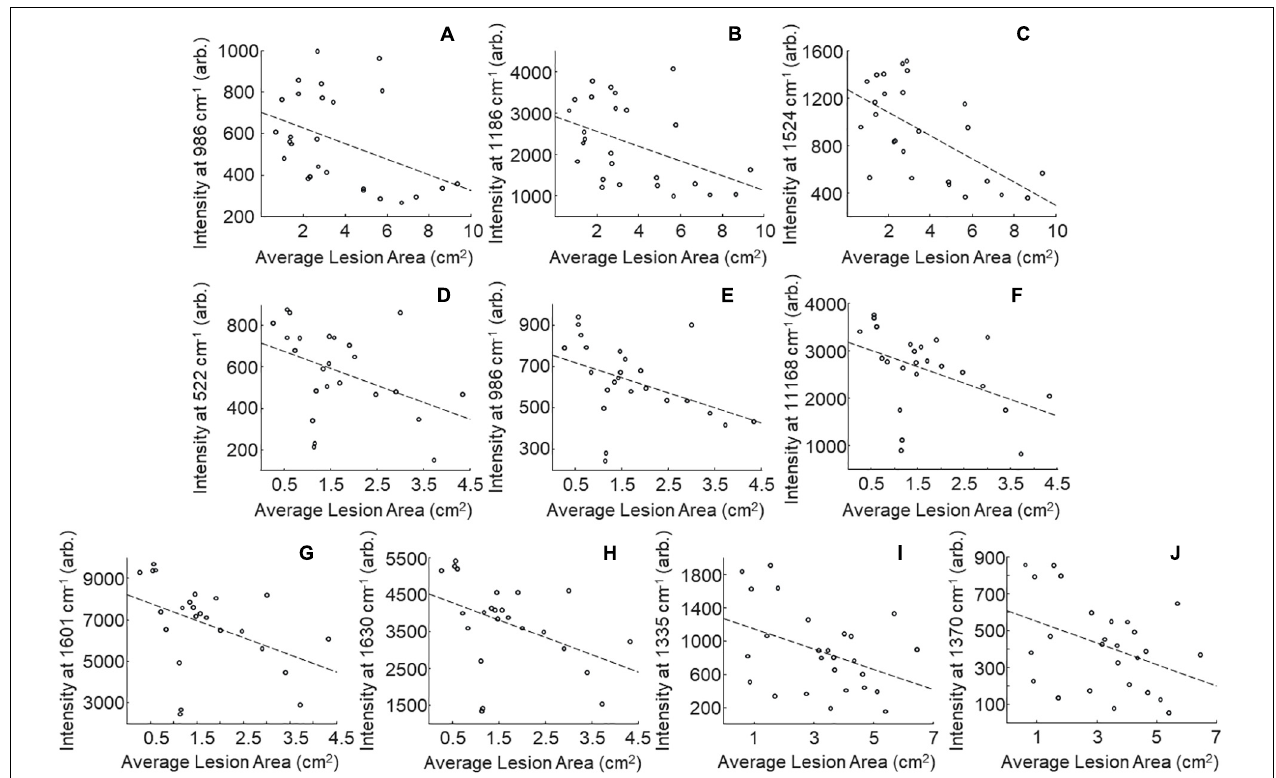
FIGURE 5 | Scatter plots of intensity at selected peaks versus averaged lesion size for field-grown plants. B73: 986 (A) , 1,168 (B) , and 1,524 (C) cm − 1 ; MP305: 522 (D) , 986 (E) , 1,168 (F) , 1,601 (G) , and 1,630 (H) ; lox4-7 : 1,335 (I) , and 1,370 (J) cm − 1 ; r - and p -values for trendlines are reported in Table 8